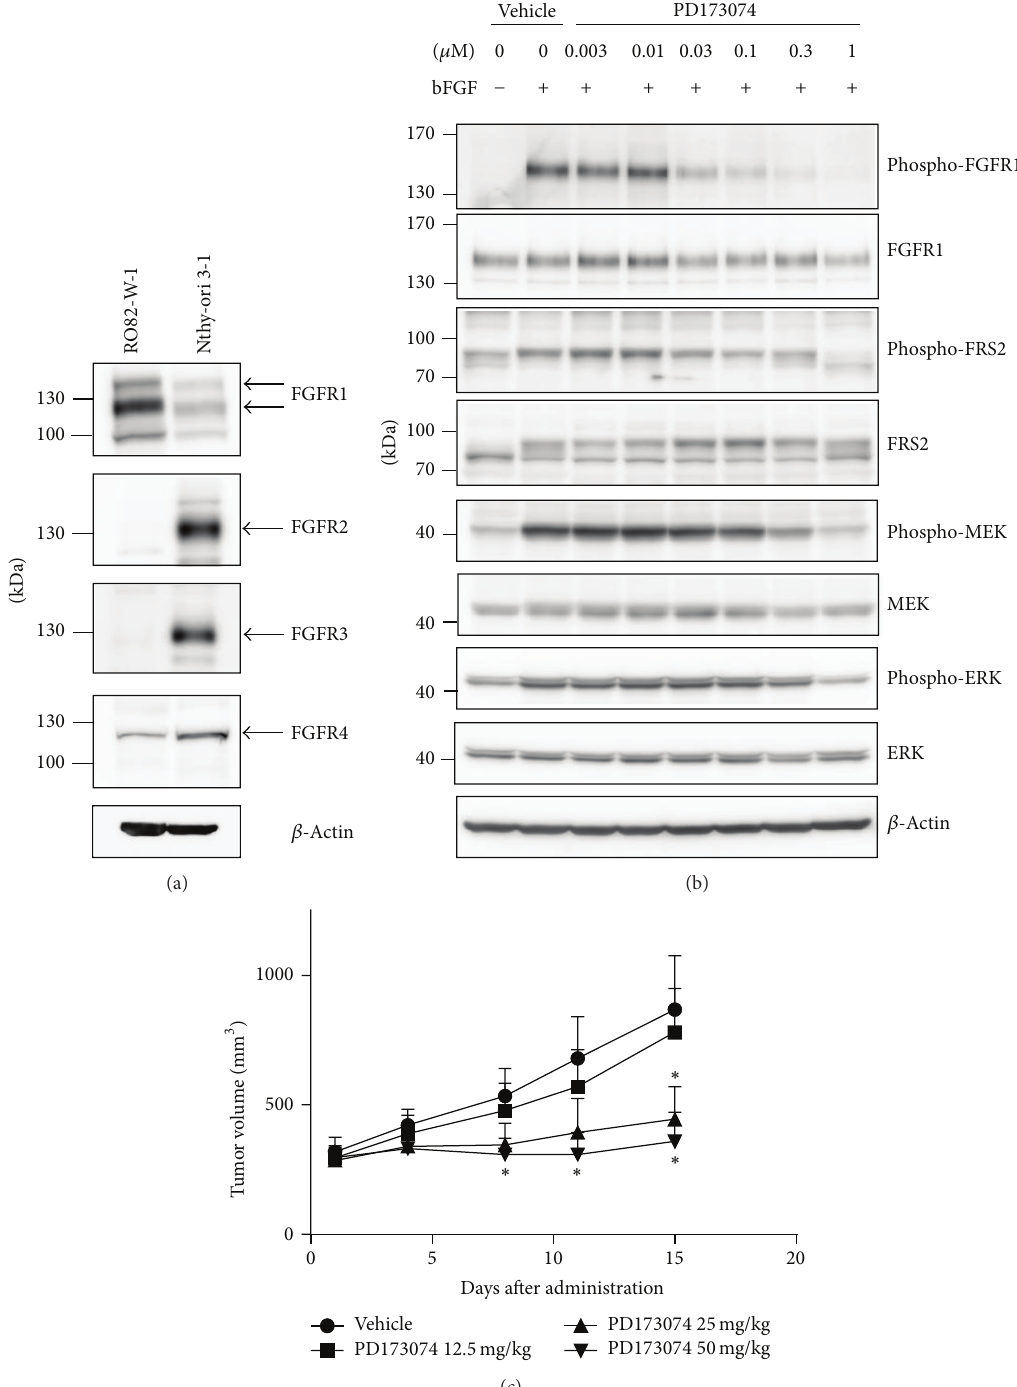
Figure 3: Effect of the selective FGFR kinase inhibitor PD173074 on the FGFR signaling pathway in human DTC RO82-W-1 cells. (a) Western blot analysis of the expression of FGF receptors in vitro. Expression levels of FGF receptors in RO82-W-1 cells were compared to those in Nthy-ori 3-1 cells (normal thyroid cells). (b) Western blot analysis of the effects of PD173074 on the phosphorylation of FGFR1 and its downstream effectors. After starvation overnight, RO82-W-1 cells were treated with PD173074 at the indicated concentrations for 1h and were then stimulated for 10 min with bFGF (20 ng/mL) and heparin before being lysed. (c) Antitumor activity of PD173074 against RO82-W-1 xenografts in nude mice. Nude mice bearing RO82-W-1 xenografts were treated orally once daily for 14 days with either vehicle or PD173074 at the indicated doses when tumor volumes reached about 300 mm 3 (day 1). The tumor volume was measured on the indicated days after administrations. Each group consisted of 5 mice. Data are shown as means ± SD. ∗ 𝑃 < 0.05 compared with vehicle-treated